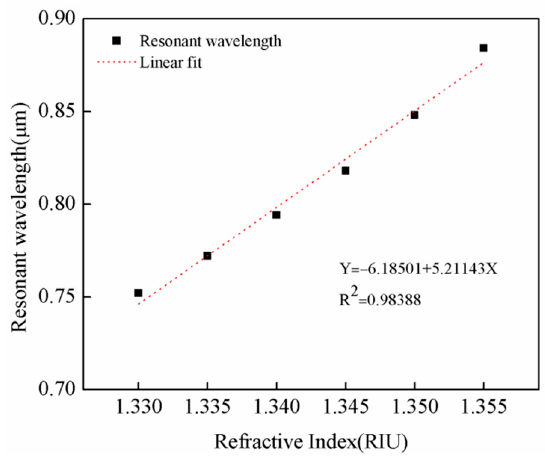
Figure 9. The fitting line of resonance wavelengths as a function of refractive index of the analyte.